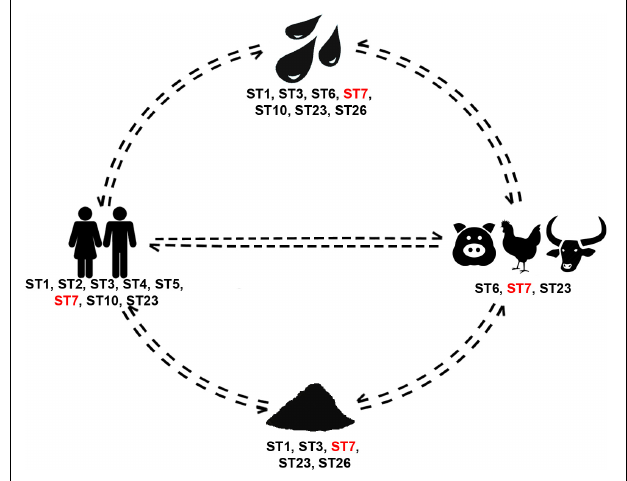
FIGURE 4 | Blastocystis subtype cycling in the rural community studied herein. Subtypes present in all sources are in red font.